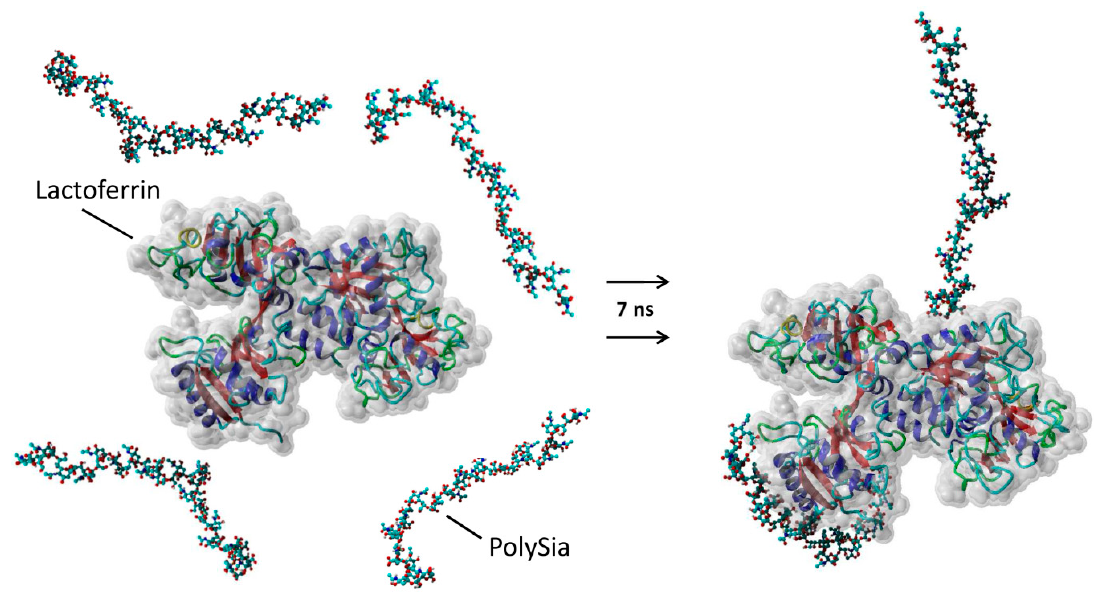
Figure 2. A molecular dynamics simulation of polysialic acid (polySia) binding to lactoferrin. Lactoferrin was placed with four polySia chains (20 sialic acid units) in a water box. After 7 calculated nanoseconds, the simulation showed two possible binding sites for polySia on the lactoferrin. Lactoferrin is displayed in a ribbon form with a dynamic surface. The polySia is shown in a ball-and-stick form, with hydrogen (gray), oxygen (red), carbon (turquoise), and nitrogen (blue) atoms.